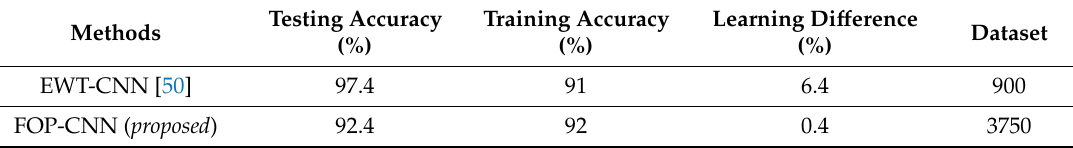
Table 6. Comparison with the best performing